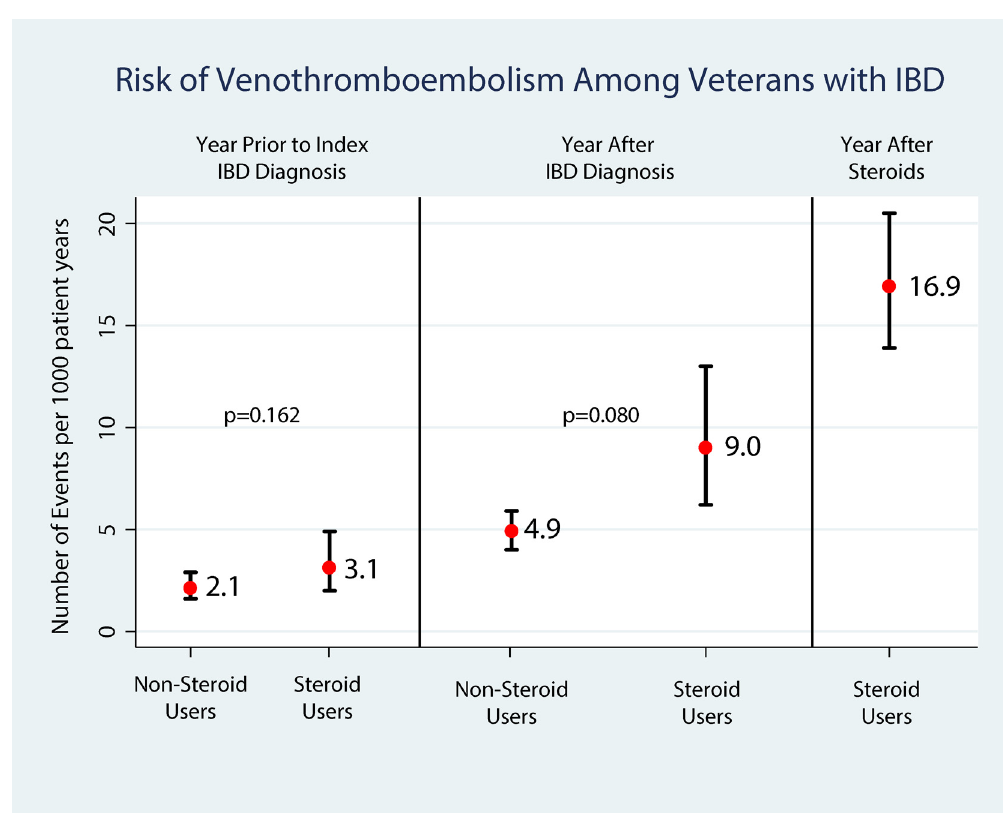
Fig 4. Risk of Venothromboembolism among Veterans with